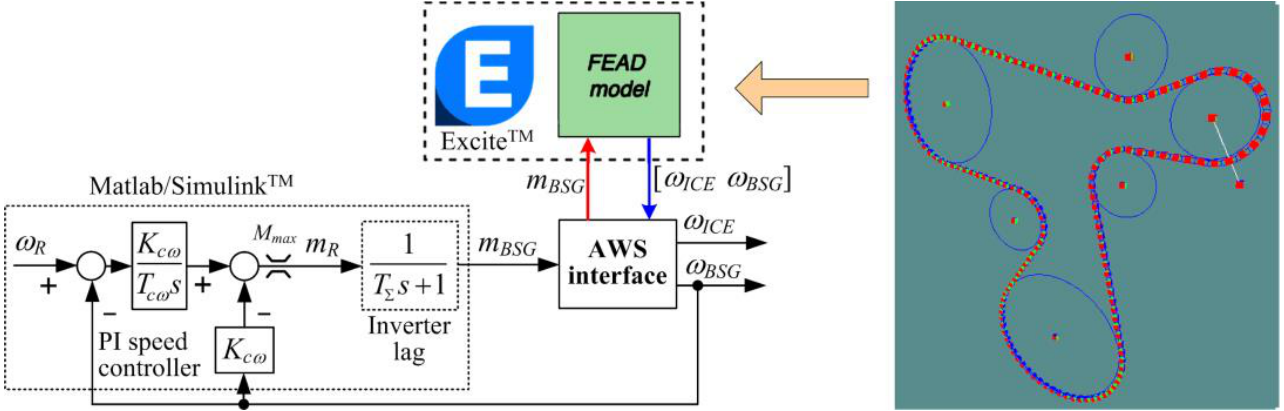
Figure 9. Principal scheme of EXCITE TM with MATLAB/Simulink TM co-simulation model with FEAD multi-body model in EXCITE TM [10].